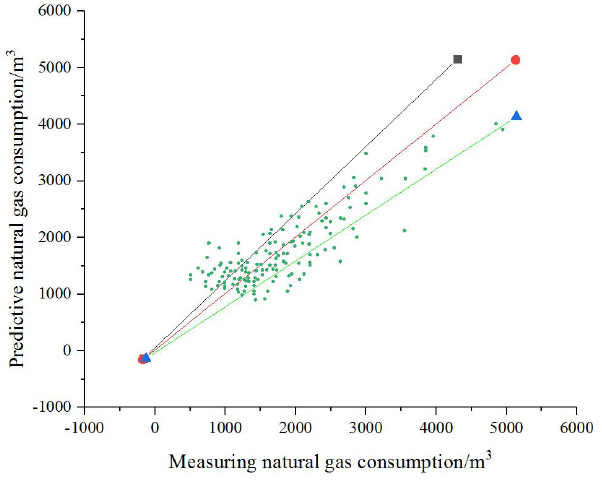
Fig. 2 Distribution scatterplot of prediction and measurement of residential average natural gas consumption.